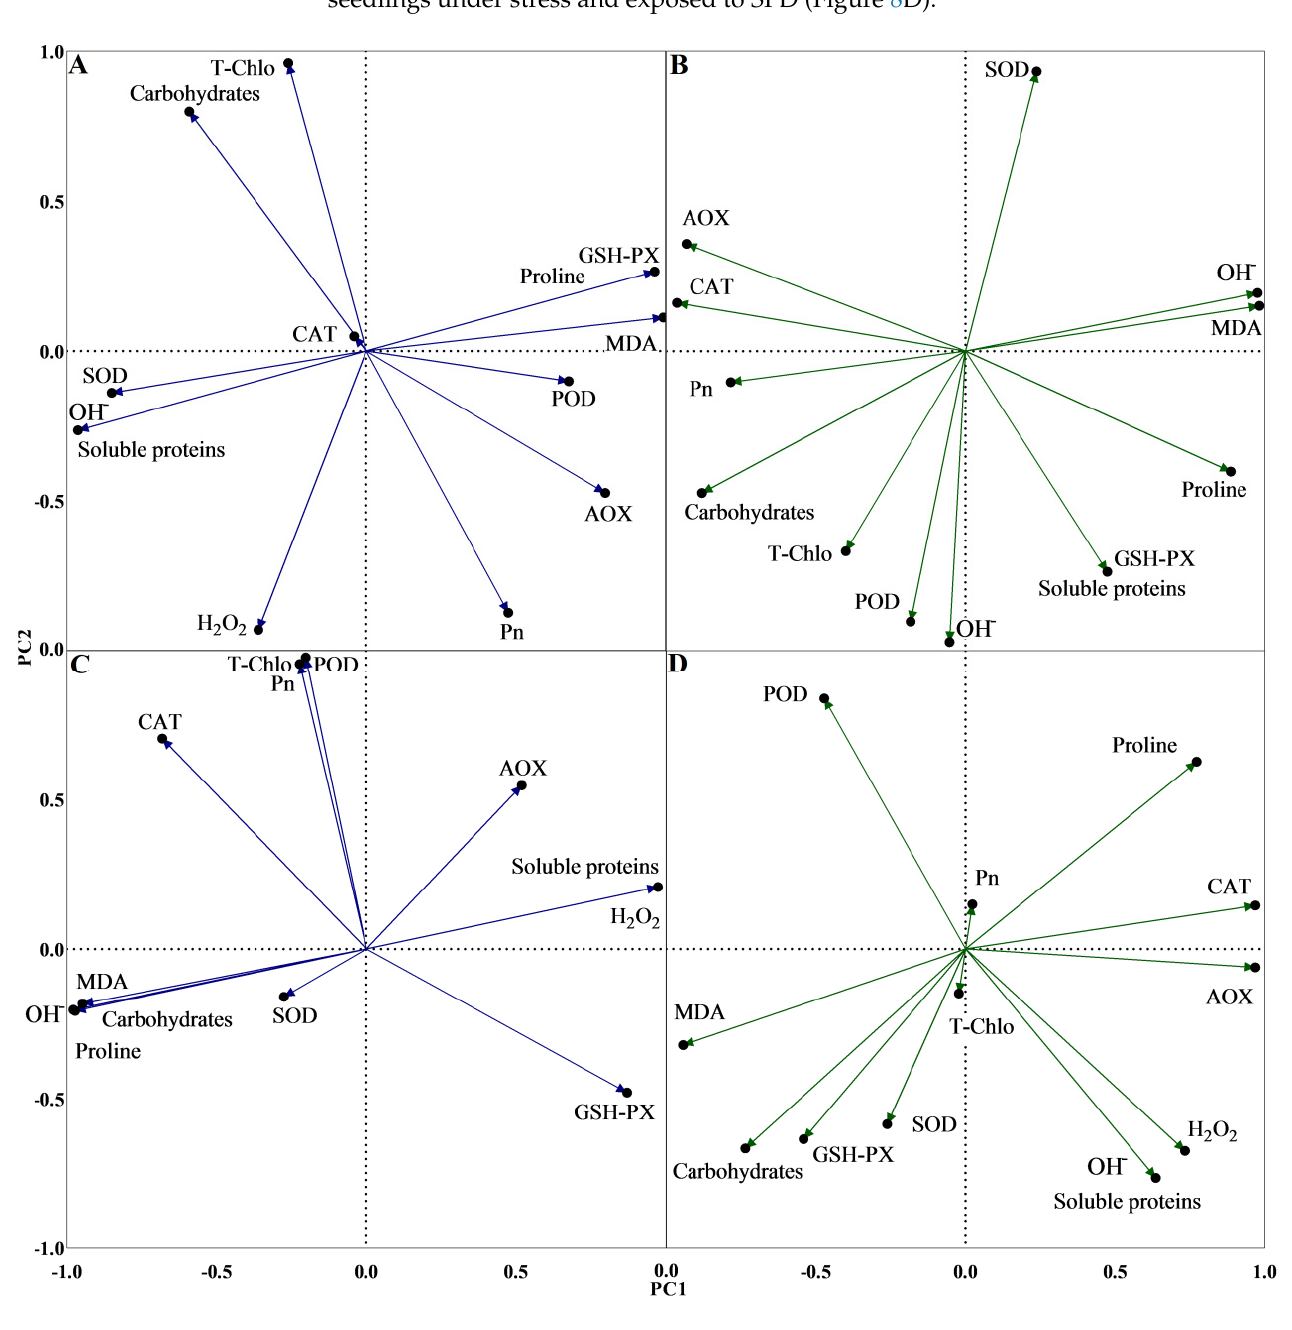
Figure 8. Loadings plot of the PCAs showing correlation between antioxidant enzymes, osmolytes, ROS, MDA, and proteins in CoH1 (( A ) WL; ( B ), WL + SPD) and in CoH2 (( C ) WL; ( D ) WL + SPD).